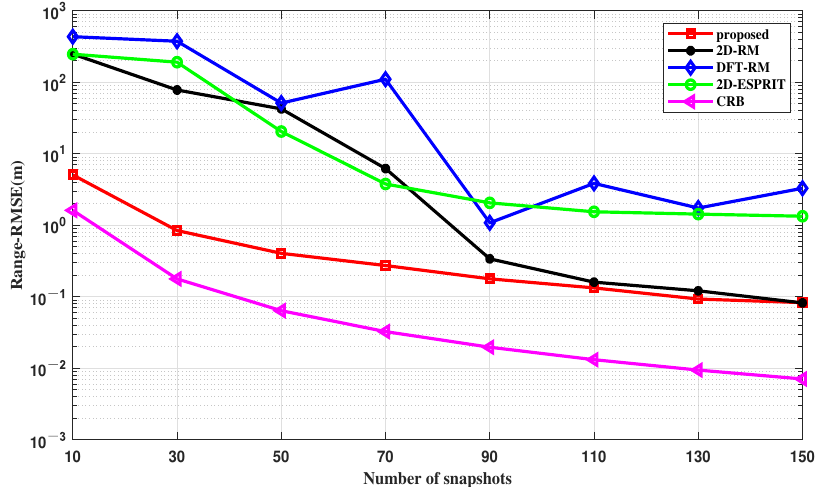
Figure 9. RMSE of the range estimation versus the